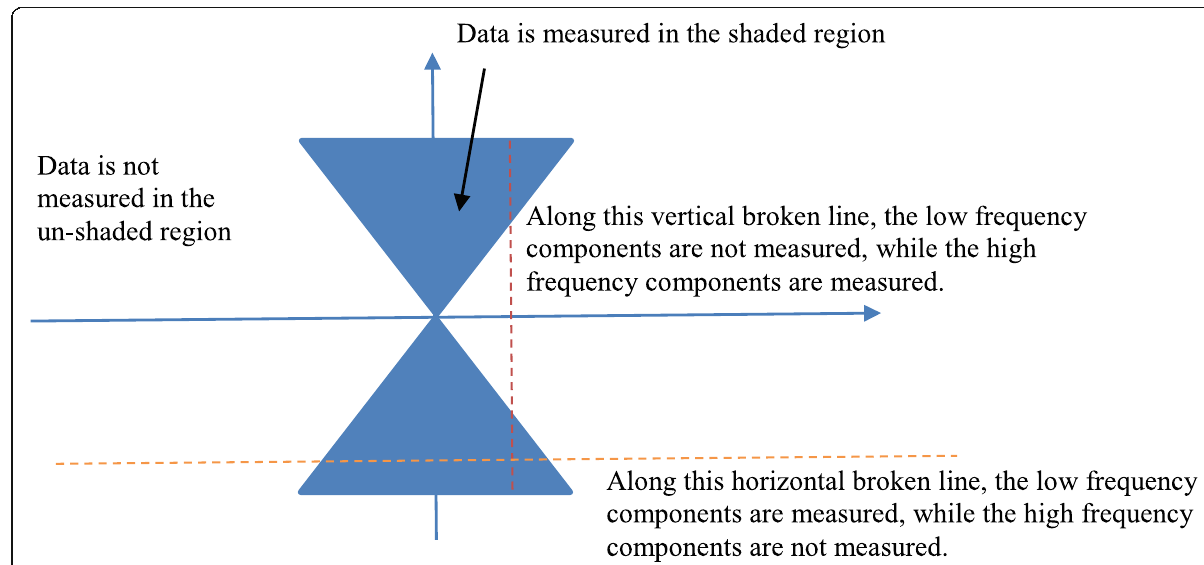
Fig. 1 A situation of limited angle data acquisition is shown in the 2D Fourier domain. The shaded area represents measured region. If a horizontal line is considered, the low frequencies are measured, while the high frequencies are not. On the other hand, if a vertical line is considered, the high frequencies are measured, while the low frequencies are